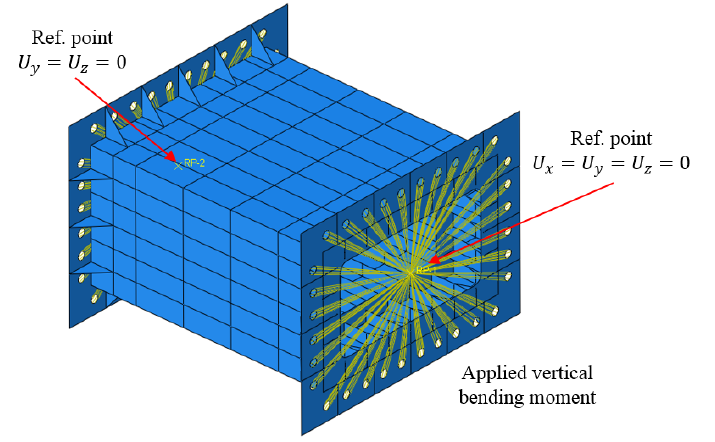
Figure 24. The numerical modeling and boundary condition for the bending simulation.